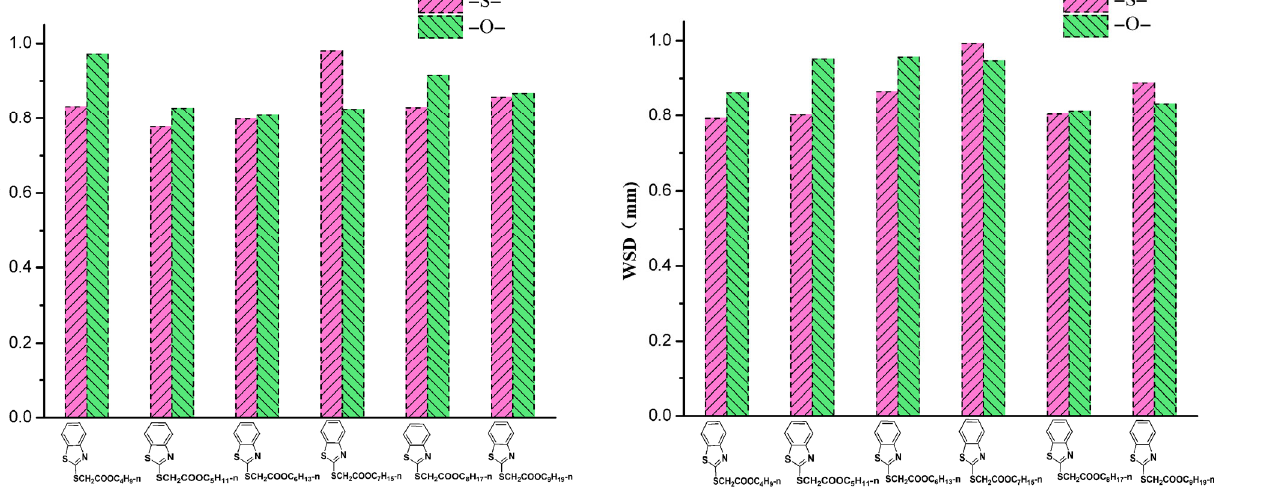
Fig. 20 The wear scar width of each steel ball when lubricating with 2-benzothiazole-S-carboxylic acid esters and their isosteres in bis(2-ethylhexyl) adipate.